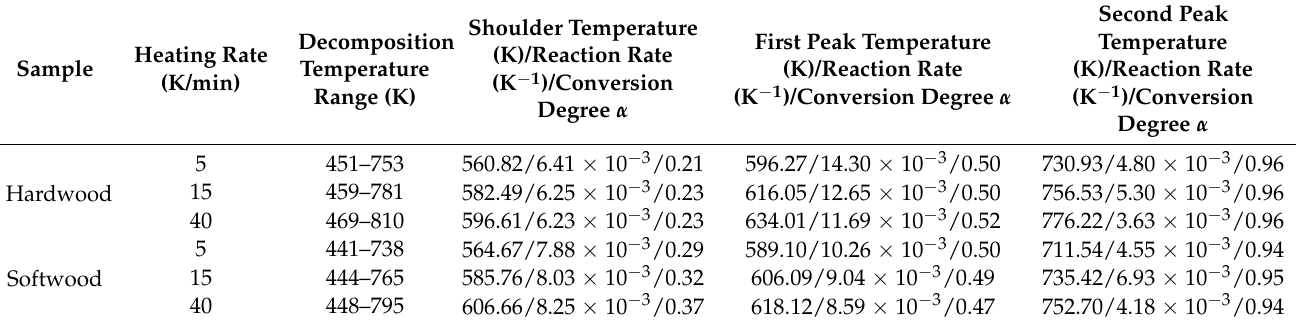
Table 2. The details of hardwood and softwood decomposition based upon α and d α /d T .